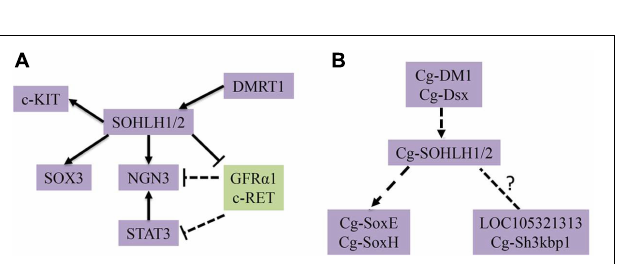
FIGURE 7 | Transcriptional regulatory networks of spermatogonial differentiation. (A) The known regulatory network in mammals are shown. (B) The predicted regulatory network in C. gigas is